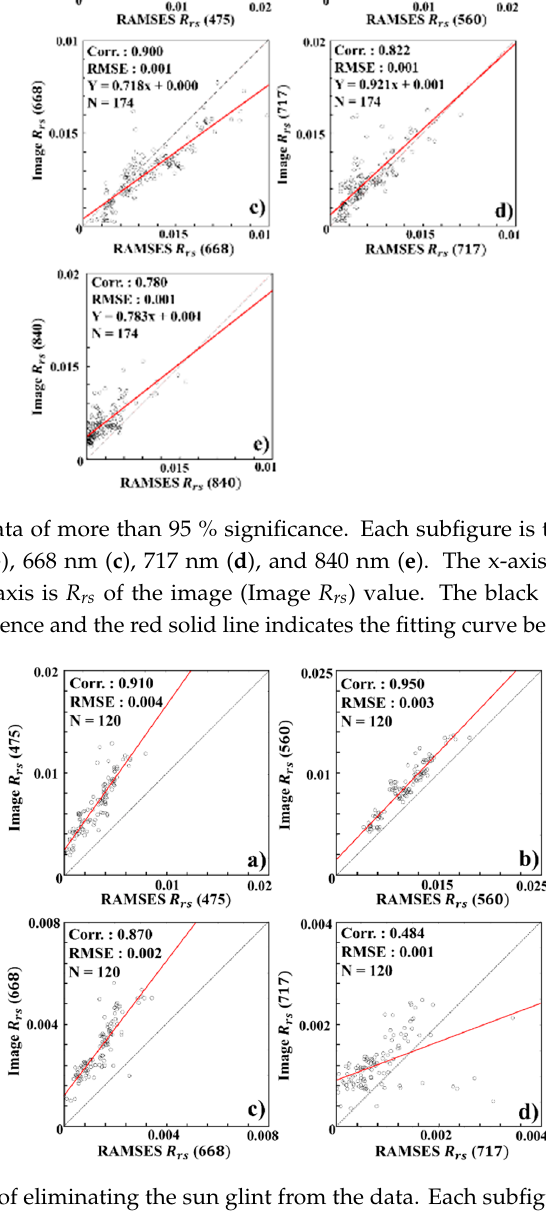
Figure 6. The process of eliminating the sun glint from the data. Each subfigure is the two different R rs at 475 nm ( a ), 560 nm ( b ), 668 nm ( c ), and 717 nm ( d ). The x-axis is R rs of the RAMSES (RAMSES R rs ) and y-axis is R rs of the image (Image R rs ) value. The black dotted line indicates a one-to-one correspondence and the red solid line indicates the fitting curve between the two data.